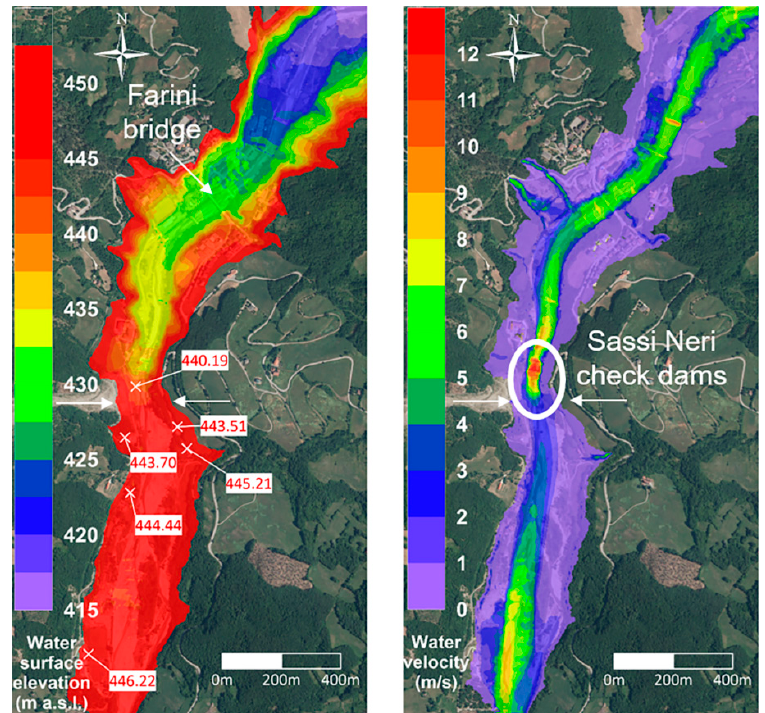
Figure 18. Computed water surface elevation (left frame) and velocities (right frame) in correspondence with the flood peak; the region of supercritical flow is highlighted. In red are reported the observed maximum water levels.